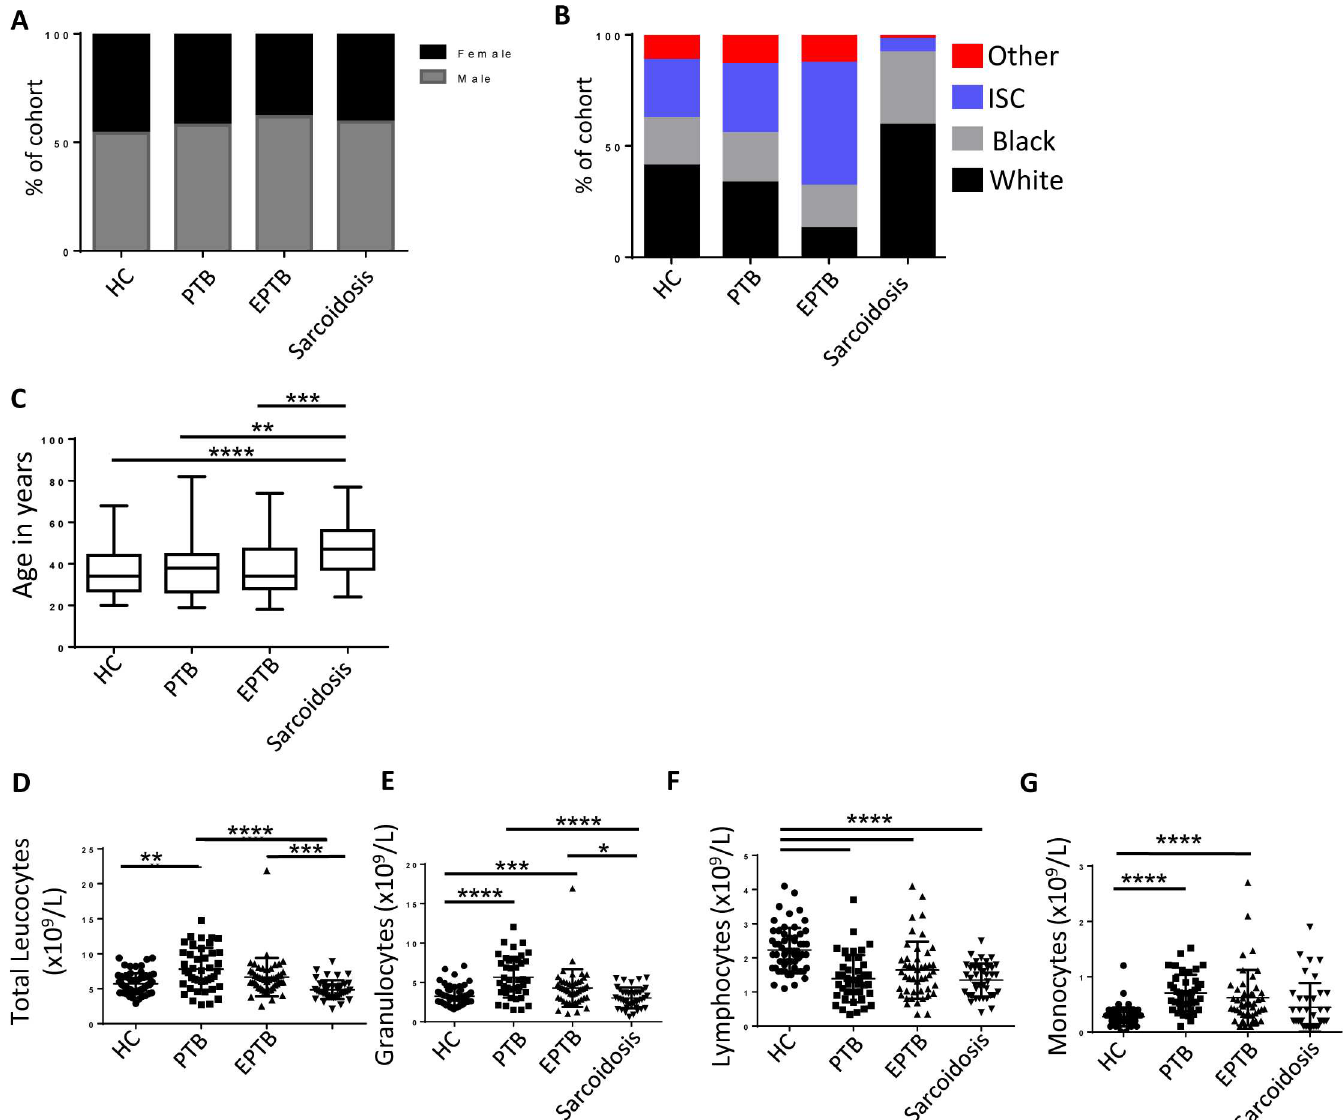
Fig 1. Clinical parameters of patients included in microarray dataset. (A) percentageof cohort by sex (B) percentageof cohort by ethnicity (ISC; Indian sub-continent) and (C) age (mean; min-max bars). Whole blood composition; (D) total leukocytes (E) Granulocytes (F) lymphocytes and (G) monocytes. Statistical tests: Kruskal Wallis with Dunn’s multiple testing